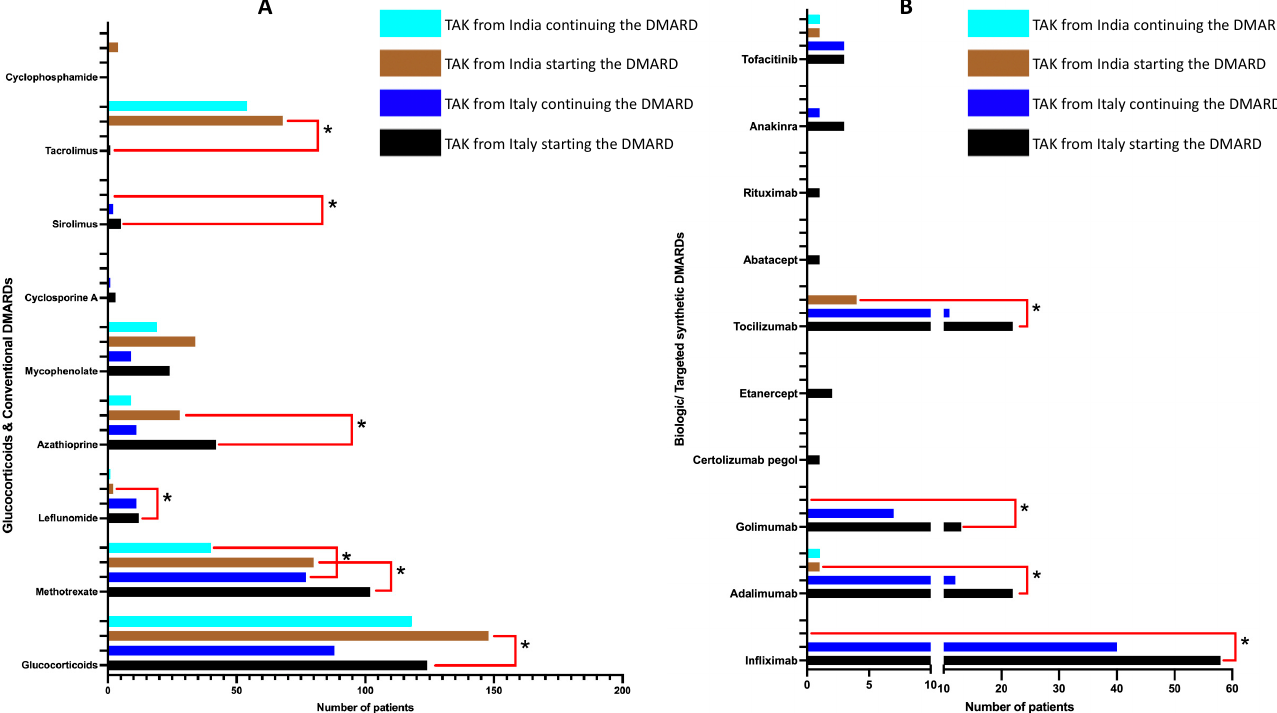
Figure 3. Use of (A) conventional DMARDs and (B) biologic or targeted synthetic DMARDs in patients with Takayasu arteritis from Italy and India. For each DMARD, black bar represents the number of patients from Italy who had used that DMARD, and blue bar represents the number of patients from Italy who were continuing that DMARD at the last recorded follow-up. Brown bar represents the number of patients from India who had used that DMARD, and cyan bar represents the number of patients from India who were continuing that DMARD at the last recorded follow-up. Those comparisons marked with an asterisk were different between the two cohorts for proportions of patients who had been started on an individual DMARD with p < 0.05. DMARD—Disease-modifying anti-rheumatic drug.